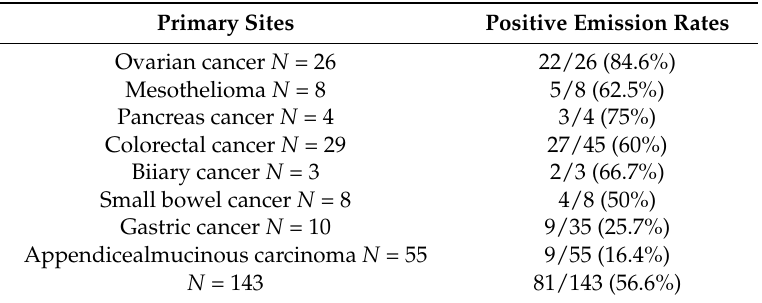
Table 3. Positive emission rates by ALA PDD [12,19]. N = number of patients.